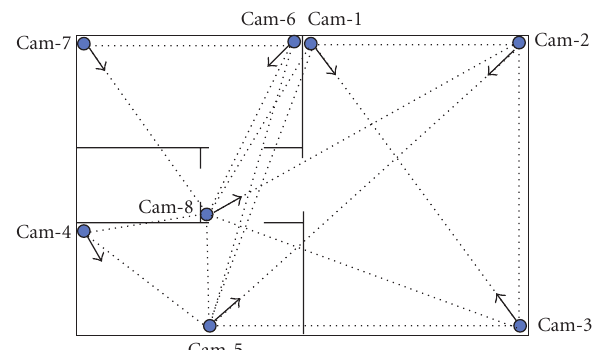
Figure 5: Topology of the visual sensor network, that is, used for testing the FireFly system [70]. The dotted lines represent the communication links between the cameras.